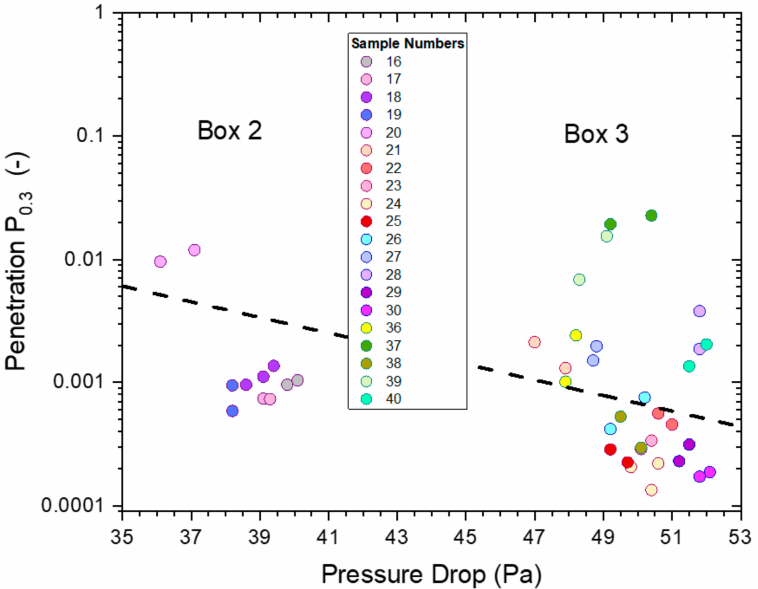
Figure 16. The penetrations from ‘whole-mask screening’ tests of untreated mask samples (P2-SD) for particles of 0.3–0.5 µ m diameter as a function of pressure drop. The different colors represent different mask samples with repeat measurements shown in matching